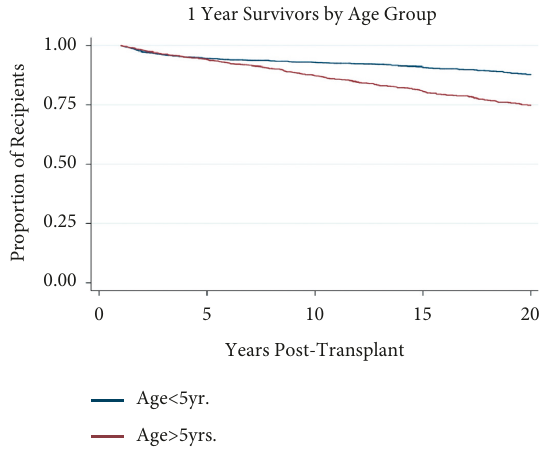
Figure 3: Kaplan–Meier survival function over time for 1-year survivor pediatric liver transplant recipients by recipient age group.